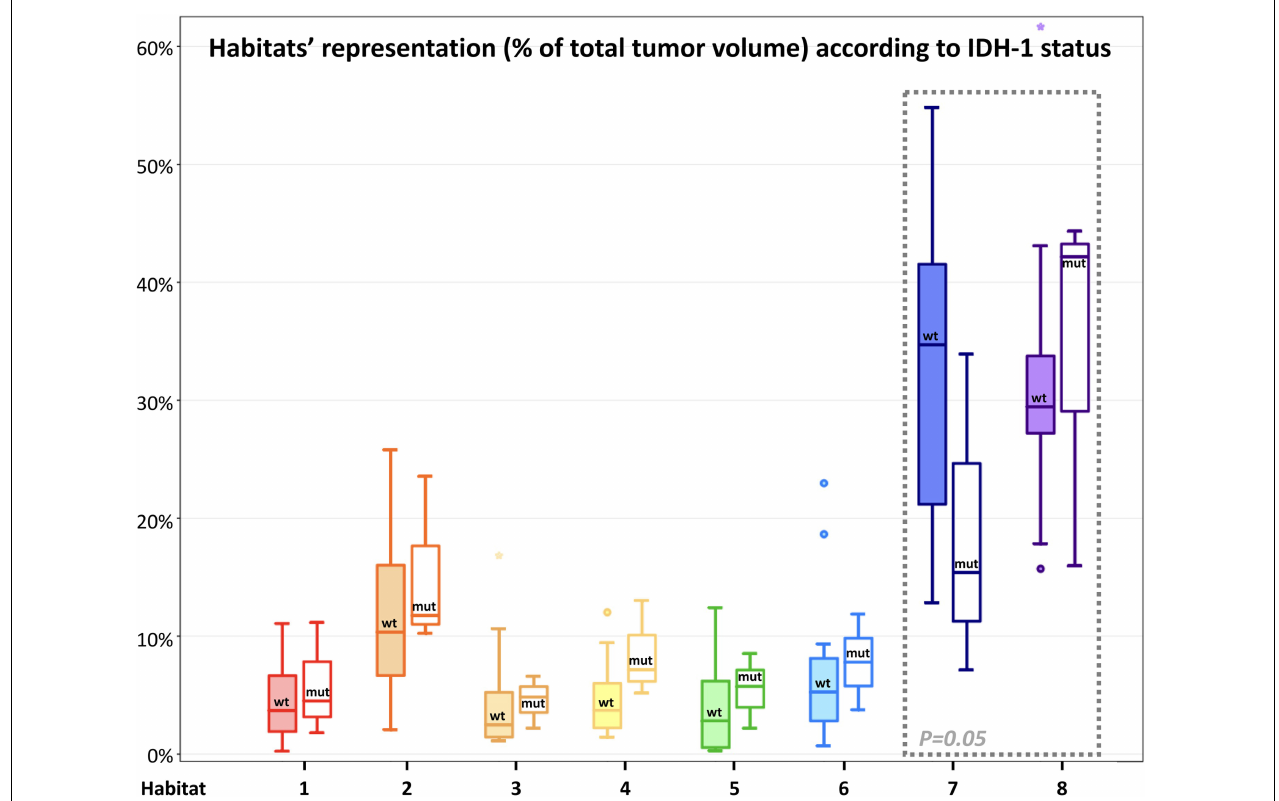
FIGURE 8 | Habitats’ representation (% of total tumor volume) according to IDH-1 status. For each habitat, the boxplot on the left (with filled color) represents IDH-1 Wild-type tumors, while the boxplot on the right (not filled with color) represents IDH-1 mutated tumors. Main differences were found in the representation of Habitat 7 (possibly embodying pure vasogenic edema) and 8 (possibly representing infiltrative edema). The former was significantly ( P = 0.05) higher in IDH wild-type tumors, while the latter was higher (not significantly) in IDH-mutated lesions; these latter two habitats were surrounded by a gray box with a dashed line to highlight the